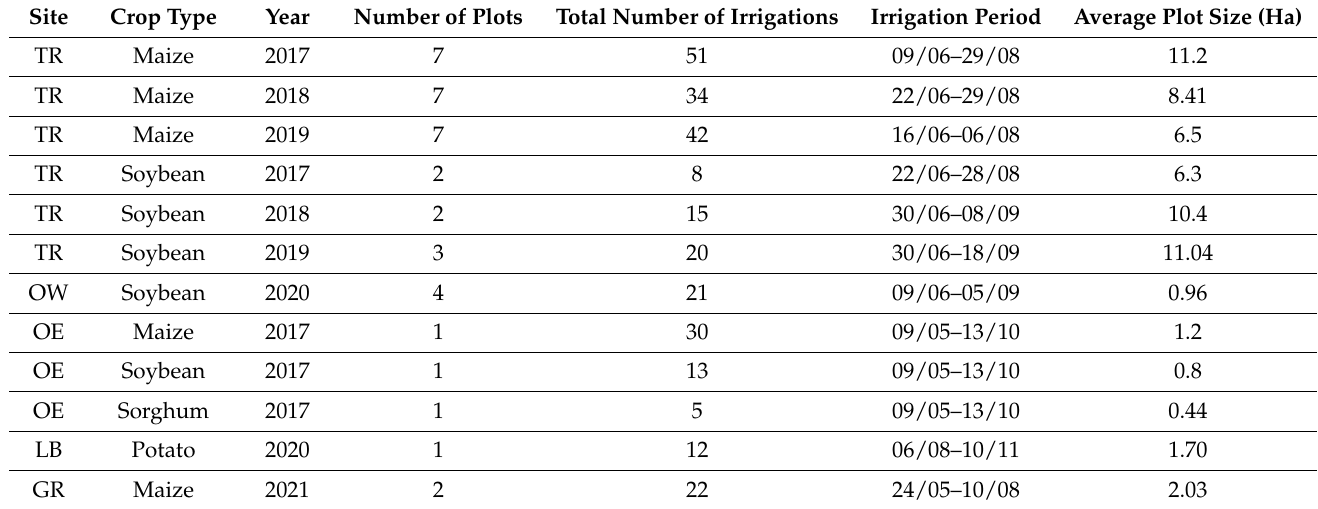
Table 1. Plots’ characteristics, crop types and irrigation information over the study sites.